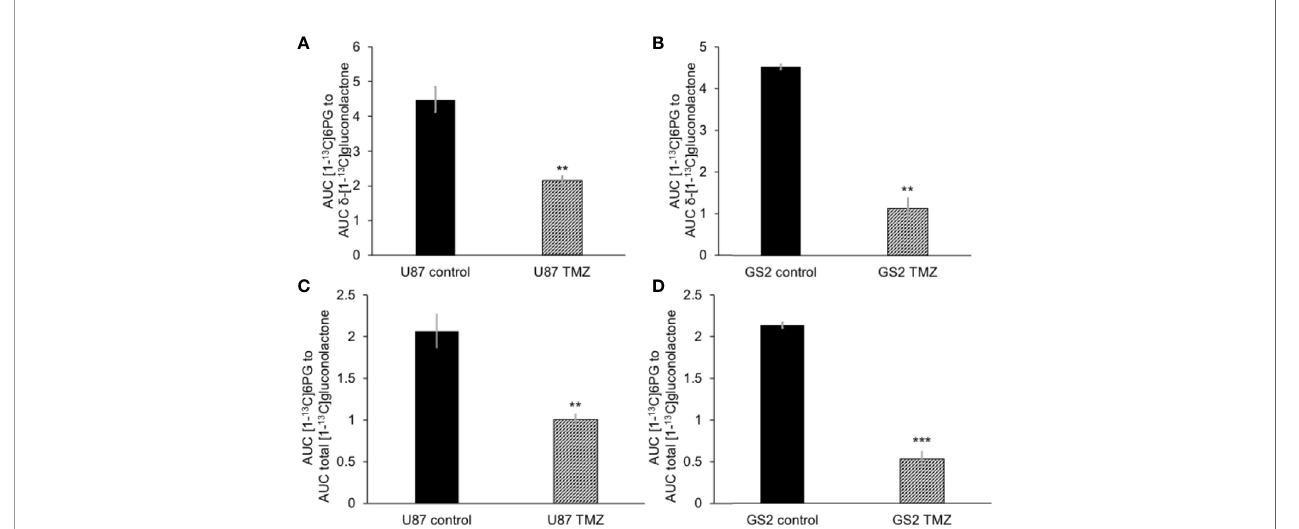
FIGURE 6 | Hyperpolarized d -[1- 13 C]gluconolactone metabolism to [1- 13 C]6PG is reduced following TMZ treatment in glioblastoma cells. The ratio of [1- 13 C]6PG to d -[1- 13 C]gluconolactone in TMZ-treated U87 (A) and GS2 (B) cells. Effect of TMZ on the ratio of [1- 13 C]6PG to total [1- 13 C]gluconolactone in the U87 (C) and GS2 (D) models (n = 3 each). ** indicates p < 0.01, *** indicates p < 0.001.